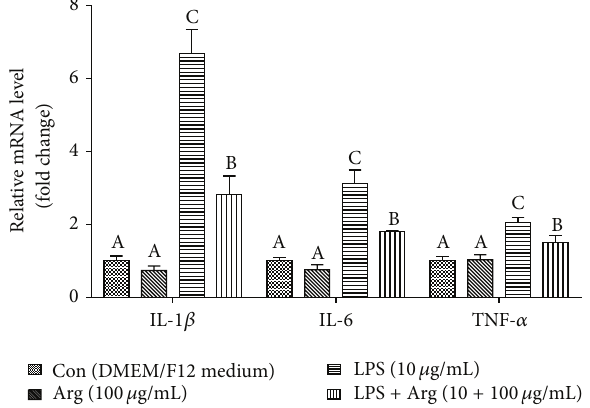
Figure 1: The effect of arginine on LPS-induced cytokines mRNA expression in bovine mammary epithelial cells (BMECs). Pure 2nd generation BMECs were starved for 16 h and then cultured for 12 h in DMEM/F12 medium containing 0 or 10 𝜇 g/mL LPS and 0 or 100 𝜇 g/mL Arg. The mRNA levels of IL-1 𝛽 , IL-6, and TNF- 𝛼 were analyzed using qPCR. 𝛽 -Actin was used as an internal reference gene. Data shown are means ± SEM of three independent exper- iments. Means with different letters (A, B, or C) are significantly different ( 𝑃 < 0.05 ) from each